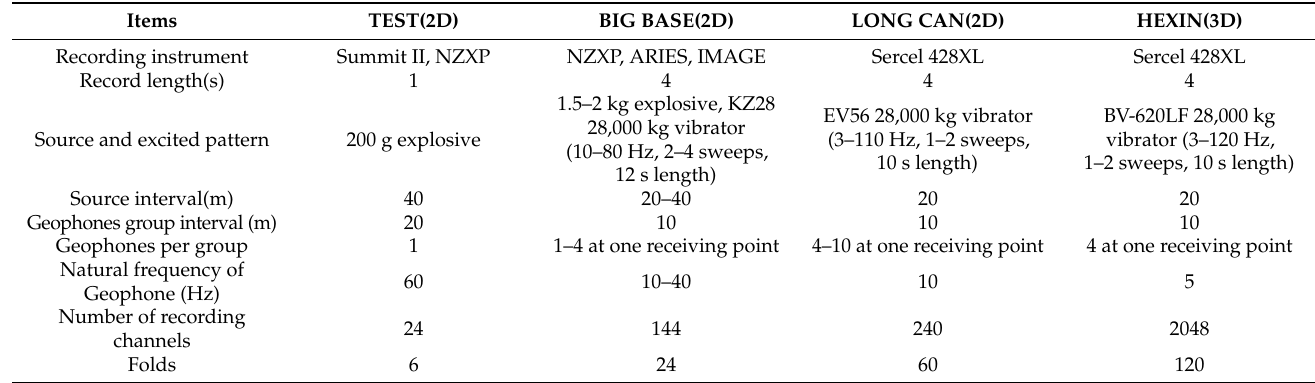
Table 2. Acquisition parameters of 2D and 3D seismic survey in four